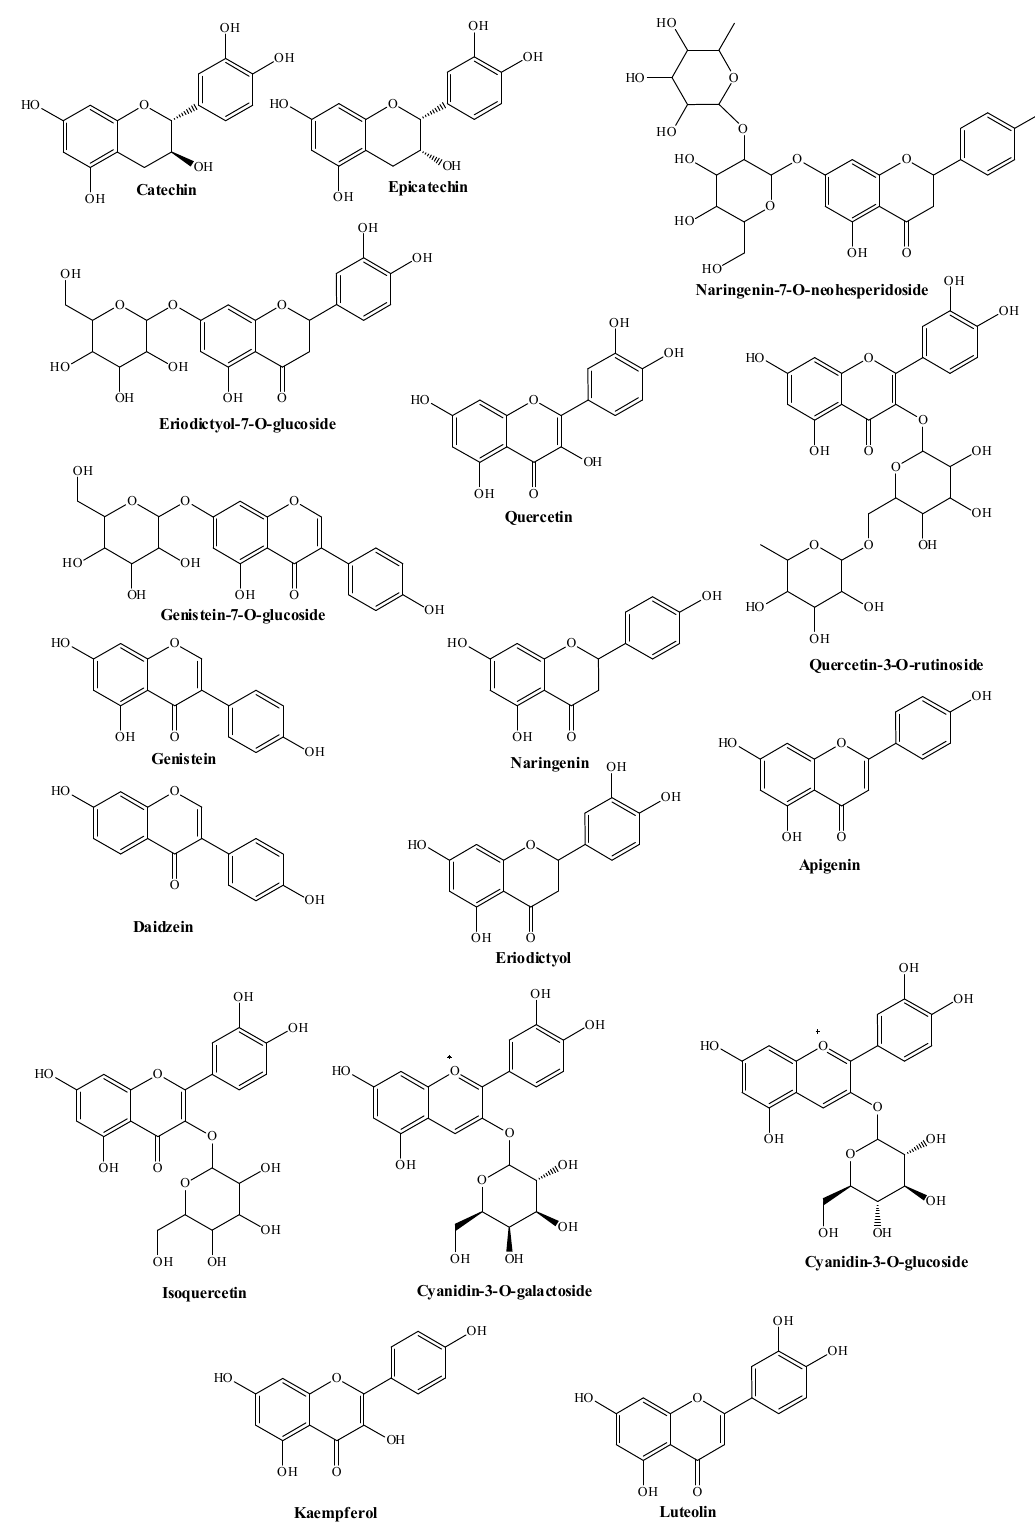
Figure 4. Chemical structures of pistachio